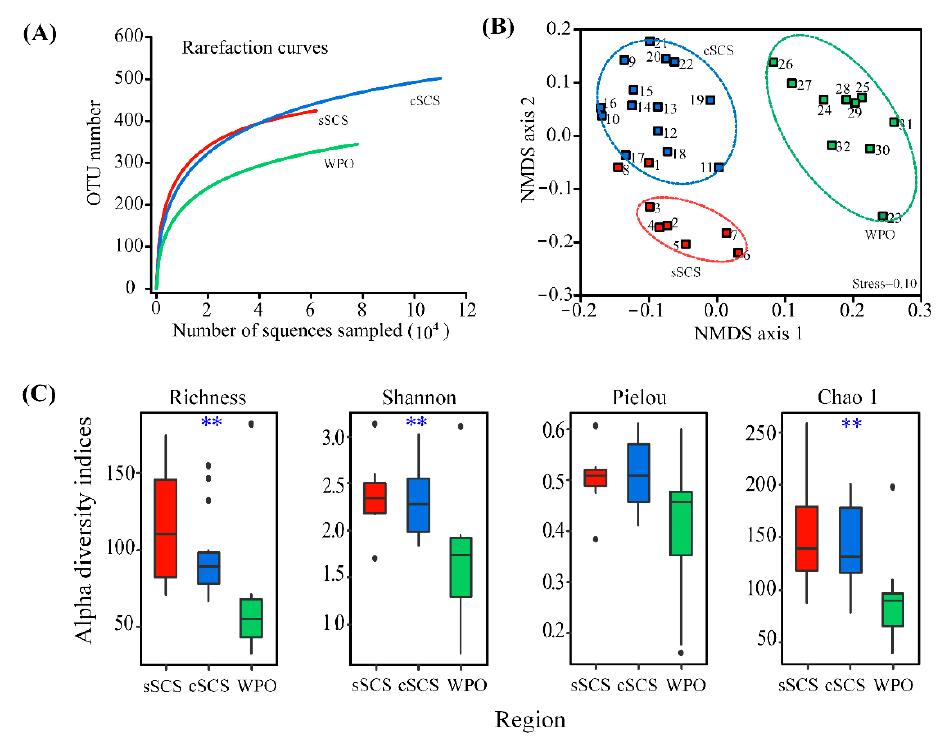
Figure A1. The rarefaction curves plateau ( A ) was calculated in the study. Non-metric multidimensional scaling (NMDS) analysis of diazotrophic communities in different stations ( B ), different groups were circled with dotted lines (sSCS, cSCS, WPO). Diversity and predicted richness of genetic community, and the Kruskal–Wallis tests of alpha diversity indices among the study areas ( C ). (** p < 0.01).